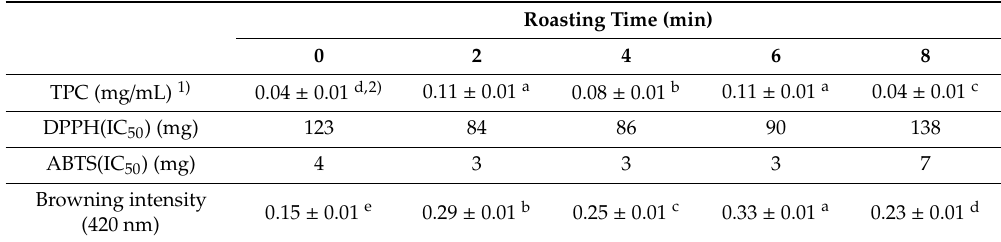
Table 5. Total phenolic content, antioxidant activity, and browning intensity in P. frutescens Britton var. acuta